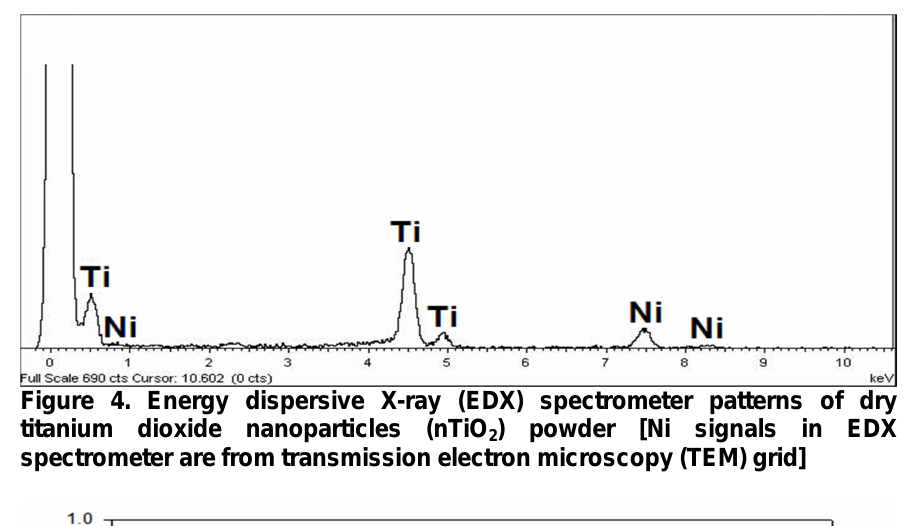
Figure 3. Size distribution of particles based on cumulative frequency determined from transmission electron microscope data in dry titanium dioxide nanoparticles (nTiO ) powder 2